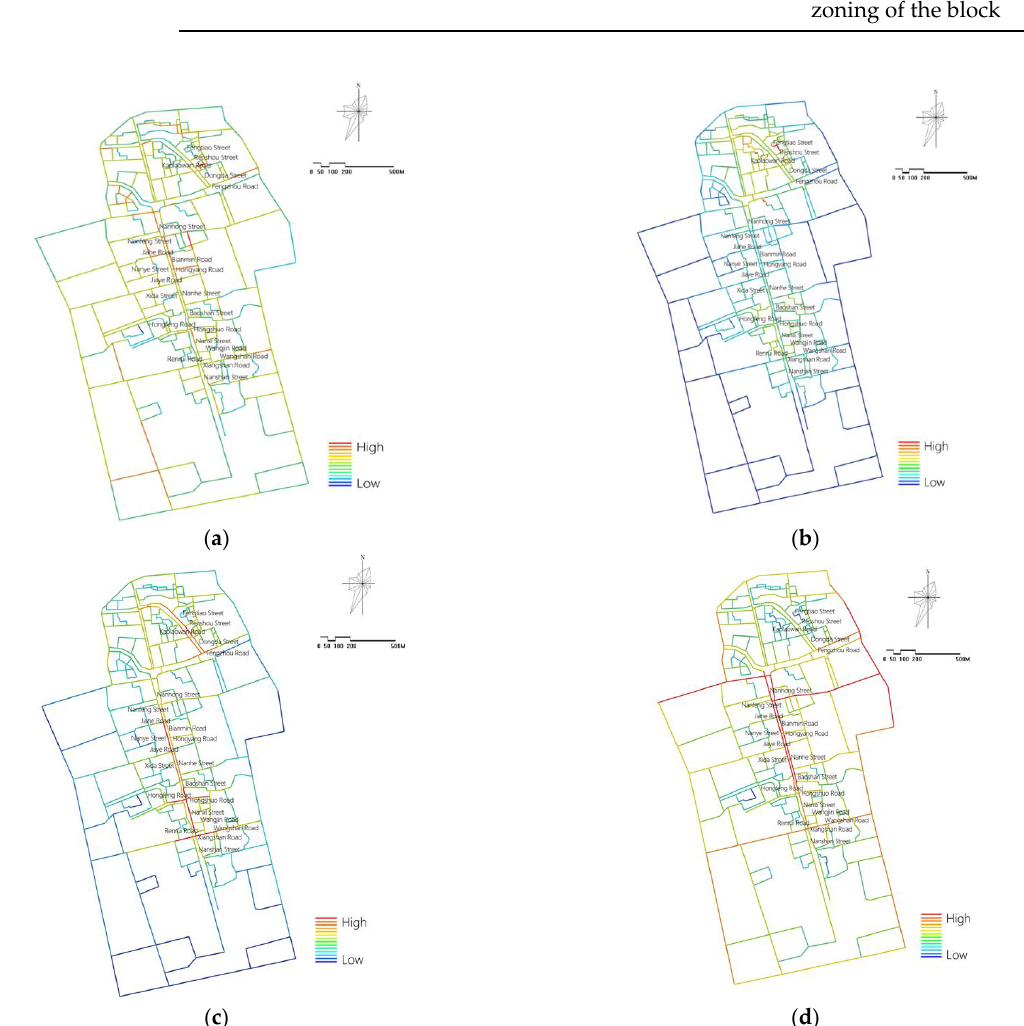
Figure 3. The space syntax model analysis result on Nanxun town: ( a ) connectivity value, ( b ) local integration value, ( c ) mean depth value, and ( d ) global integration value.